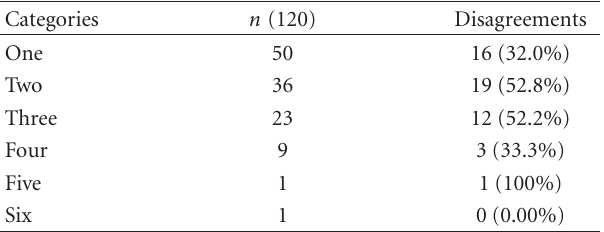
Table 4: Frequencies of number of comorbid diagnoses.